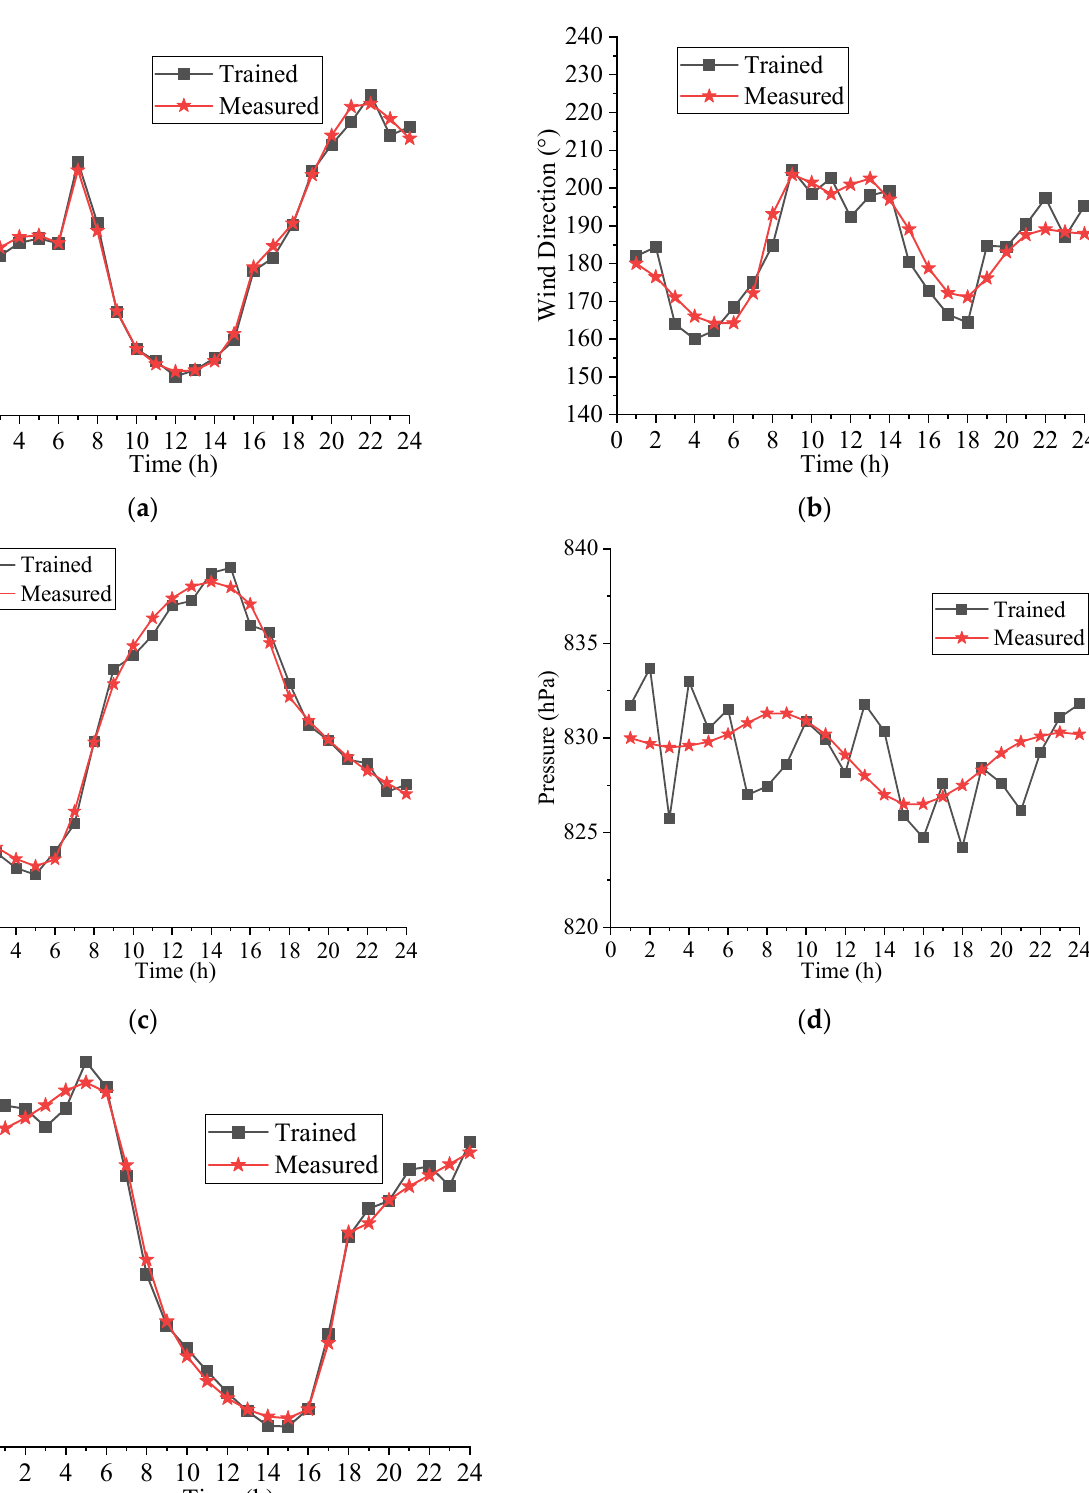
Figure 9. Comparison between the trained and measured results. ( a ) Wind speed. ( b ) Wind direction. ( c ) Temperature. ( d ) Barometric pressure. ( e ) Relative humidity.